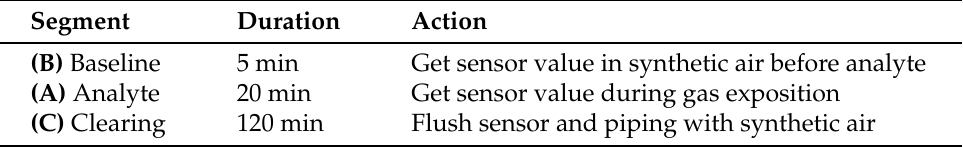
Figure 1. Measurement of a Cr 2 O 3 sensor, sintered with 800 ˝ C for 720 min, operated at 450 ˝ C, exposed to 5 ppm Acetone. The section between the dotted lines is the analyte exposition. The slightly toned down color before and after the analyte are the baseline and clearing parts of the measurement. Table 1. Basic structure of an individual